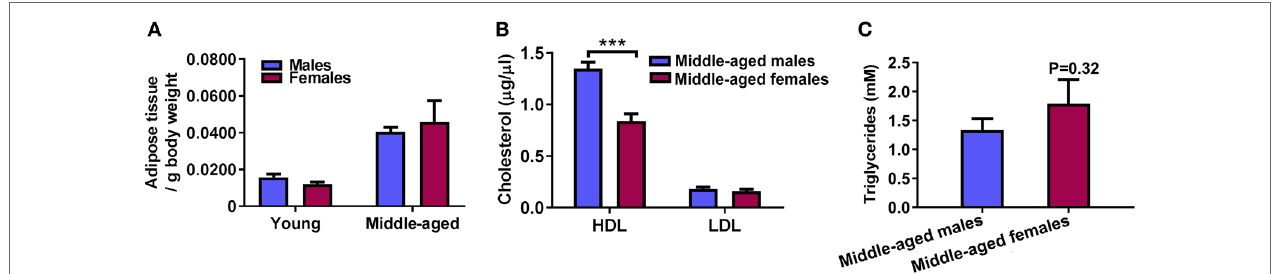
FigUre 1 | Age-induced increase in adipose tissue mass and negatively shifted lipid profile in middle-aged females. (a) Perigonadal (epididymal in males and parametrial in females) adipose tissue mass normalized to body weight in young (3–4 months) and middle-aged (15–16 months) mice. Two-way ANOVA effect of age: p < 0.001, n = 9. (B) Plasma high-density lipoprotein (HDL) cholesterol and low-density lipoprotein cholesterol (LDL) in middle-aged mice. *** p < 0.001 unpaired t -test, n = 10. (c) Plasma triglycerides in middle-aged male and female mice. p = 0.32 unpaired t -test, n =